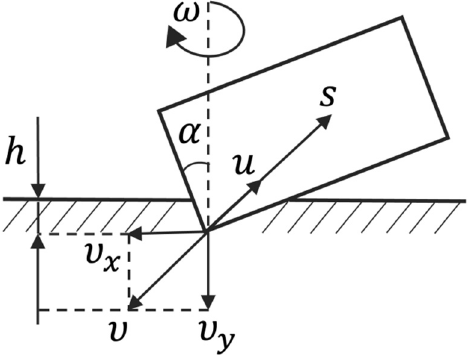
Figure 4. Diagram of directional indention of PDC-indenter, where α —angle of inclination of the bit indenter, degrees; u —speed of the reflected mechanical wave, m/s; S —impulse, N×s.